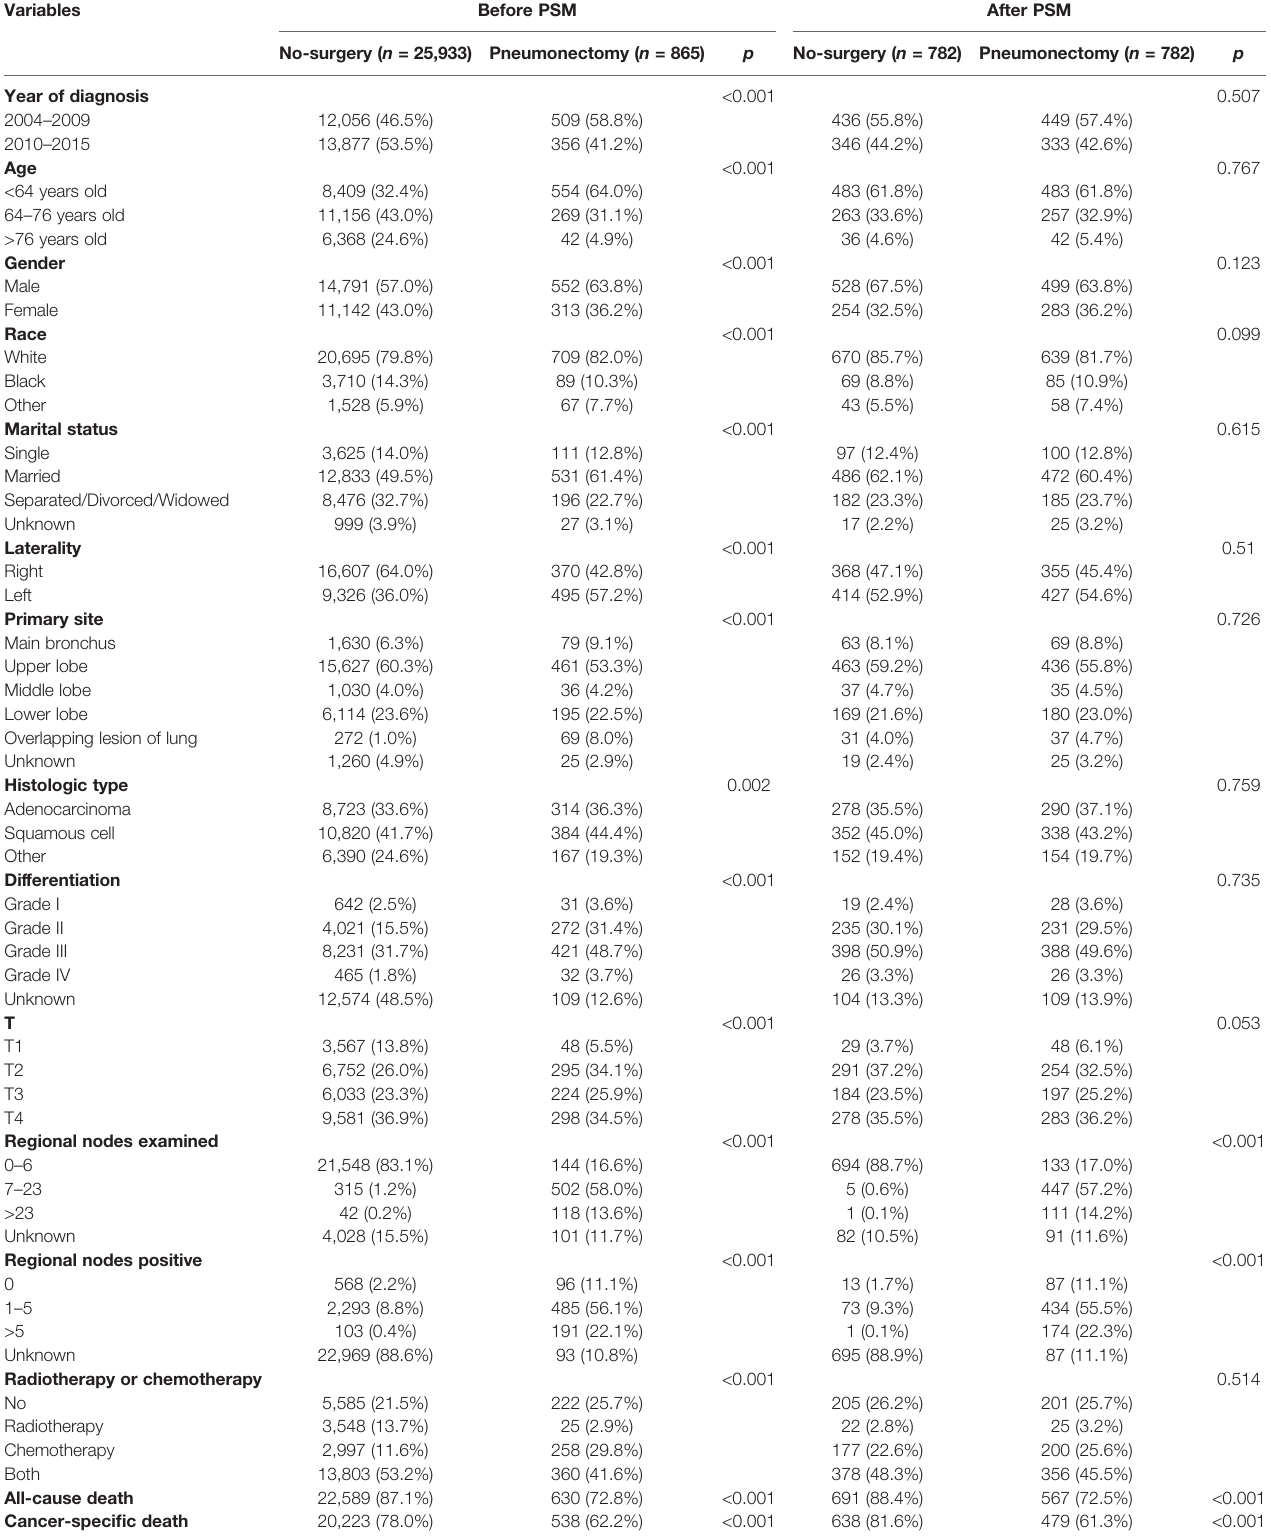
TABLE 1 | Baseline characteristics of stage T1 – 4N2M0 NSCLC patients.